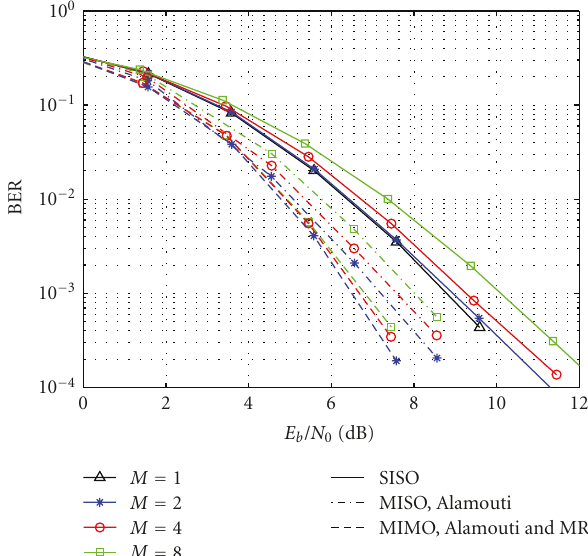
Figure 4: Coded performance for B-IFDMA with instantaneous data rate 2.22 Mbps, that is, Q = 64 subcarriers per user with normalized antenna